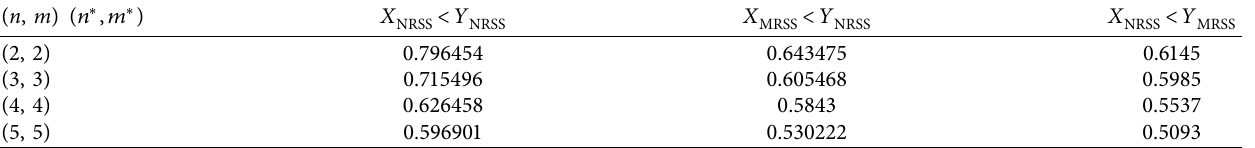
Figure 13: Plots of density, CDF, and survival of the GED for data set Table 11: ML estimator of R based on different sampling designs for the second application.